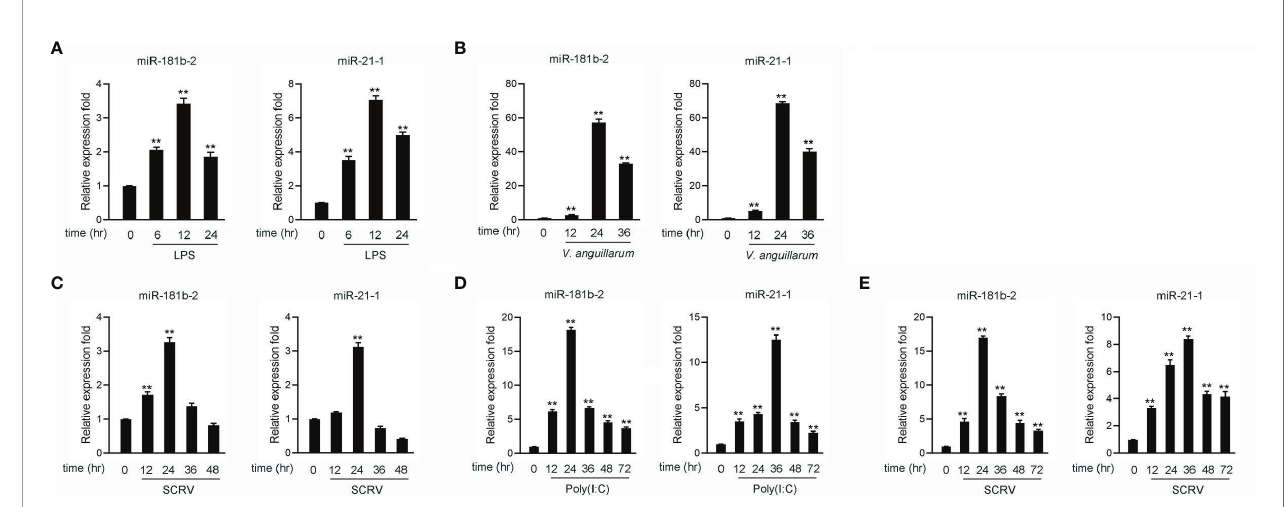
FIGURE 1 | The expression analysis of miR-21-1 and miR-181b-2 following bacterial infection and virus injection. (A) The expression of miR-21-1 and miR-181b-2 in LPS-stimulation MBrC cells. (B) The expression of miR-21-1 and miR-181b-2 in miiuy croaker liver samples after V. anguillarum infection. (C) The expression of miR-21-1 and miR-181b-2 in the MBrC cells of SCRV injection. (D) The expression of miR-21-1 and miR-181b-2 in miiuy croaker spleen after poly(I:C) stimulation. (E) The expression of miR-181b-2 and miR-21-1 in miiuy croaker spleen after SCRV injection. The expression of miR-181b-2 and miR-21-1 were measured by qRT- PCR and normalized to 5.8S rRNA. All data are presented as the means ± SE from three independent triplicate experiments. ** p < 0.01, versus the